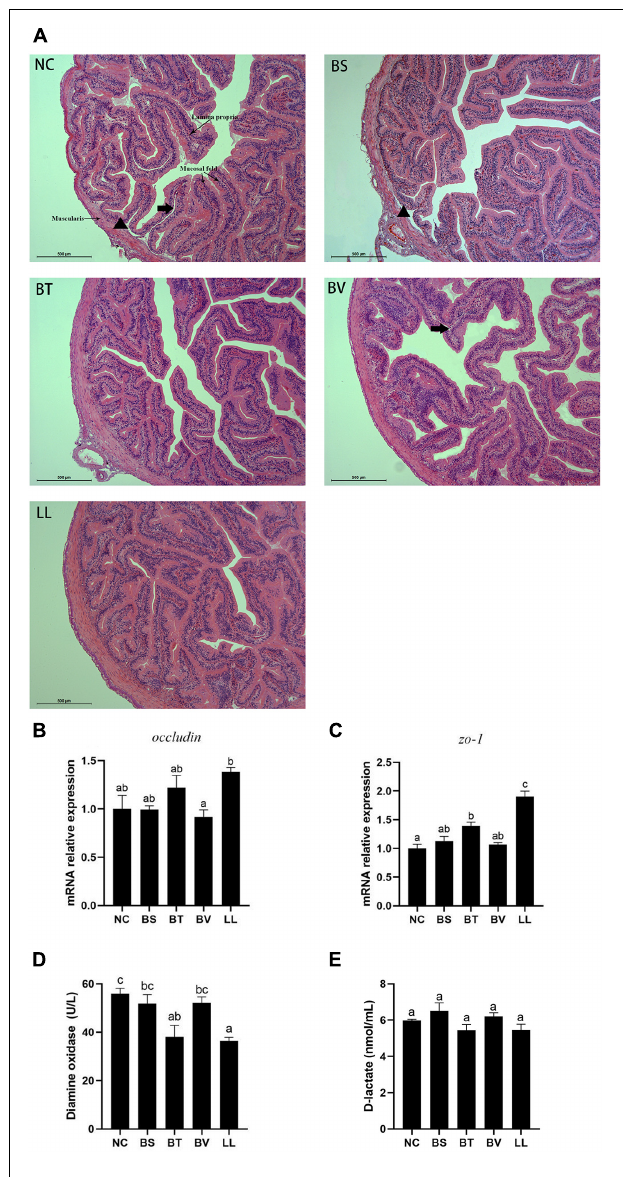
FIGURE 3 | (A) Jejunal morphology of bullfrog using H&E staining. The arrow pointed to the separation between lamina propria and mucosa. The triangle pointed to the separation between submucosa and muscularis. (B,C) Expression of tight junction proteins genes ( occludin and zo-1 ) in jejunum of bullfrog. (D,E) Intestinal epithelial permeability indicators (diamine oxidase and D -lactate) in serum of bullfrog. Bars with different letters were significantly different ( p < 0.05). zo , zonula occludens; NC, control diet; BS, control diet containing 1 × 10 7 CFU/g of Bacillus siamensis ; BT, control diet containing 1 × 10 7 CFU/g of Bacillus tequilensis ; BV, control diet containing 1 × 10 7 CFU/g of Bacillus velezensis ; and LL, control diet containing 1 × 10 7 CFU/g of Lactococcus lactis .